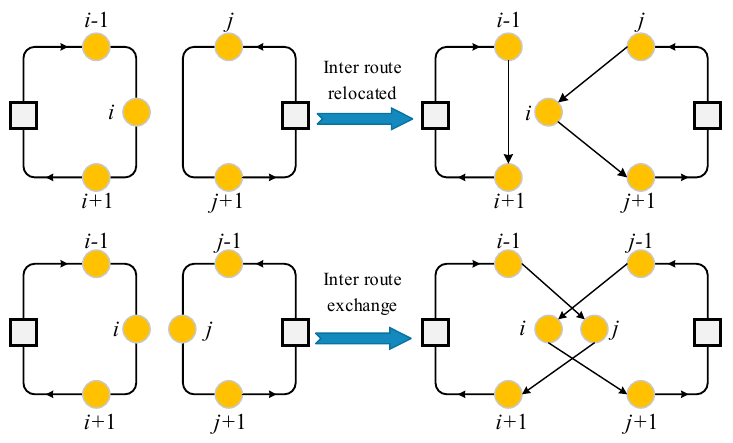
Figure 6. An example of interroute exchange and interroute relocated.